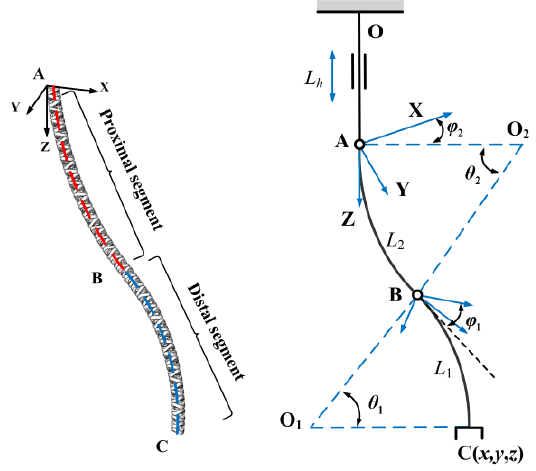
Figure 7. Inverse kinematics model of the continuum robot.